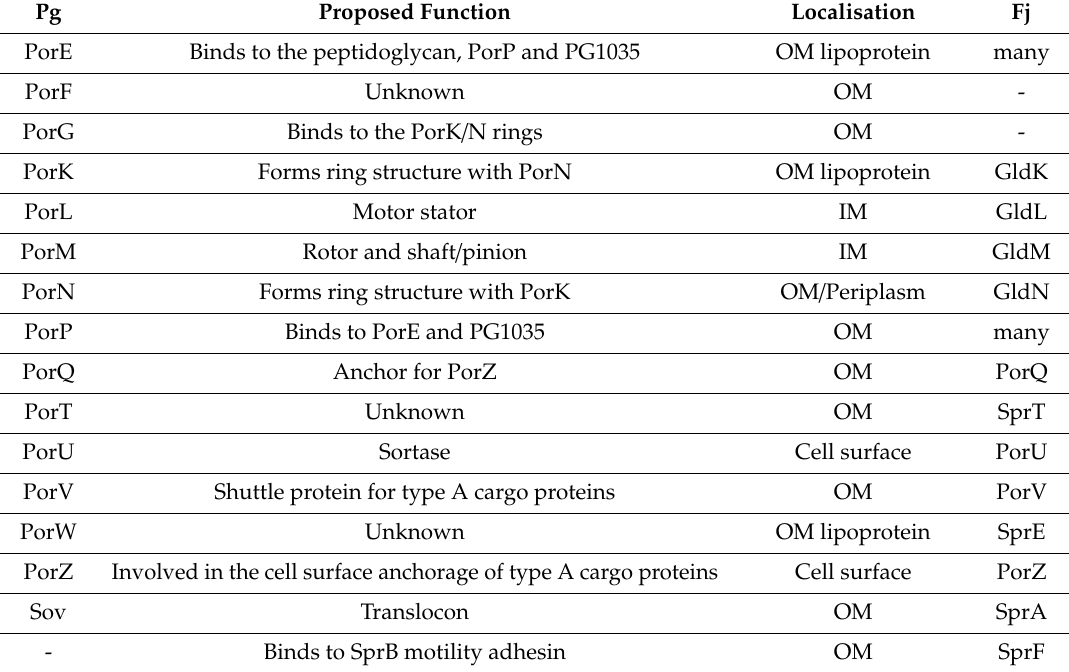
Table 1. Localisation and proposed function of the T9SS protein